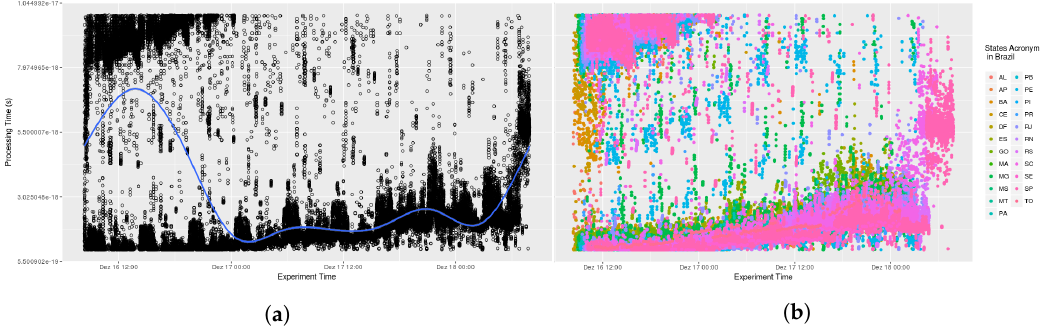
Figure 12. Scenario 04—Processing Time. ( a ) Stations in the whole country of Brazil; ( b ) Stations grouped by states.